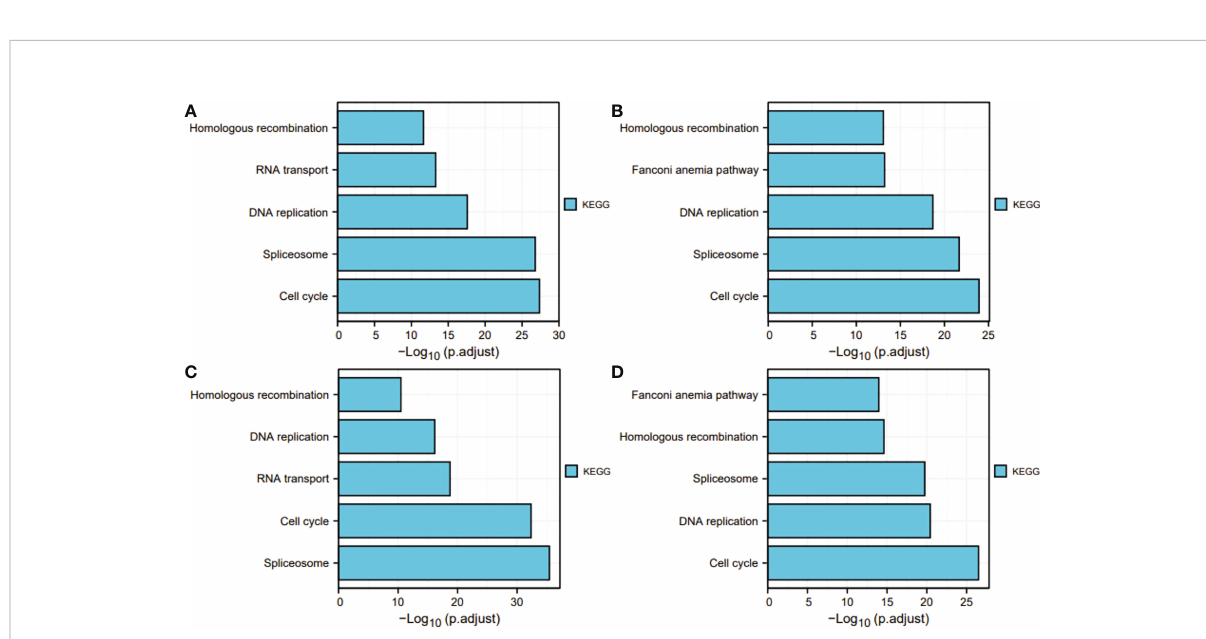
FIGURE 8 KEGG pathway enrichment analysis of SKA1 (A) , SKA2 (B) , SKA3 (C) co-expression genes, and intersection co-expression genes among with SKA1/2/3 (D) . SKA, spindle and kinetochore associated complex subunit. KEGG, Kyoto Encyclopedia of Genes and